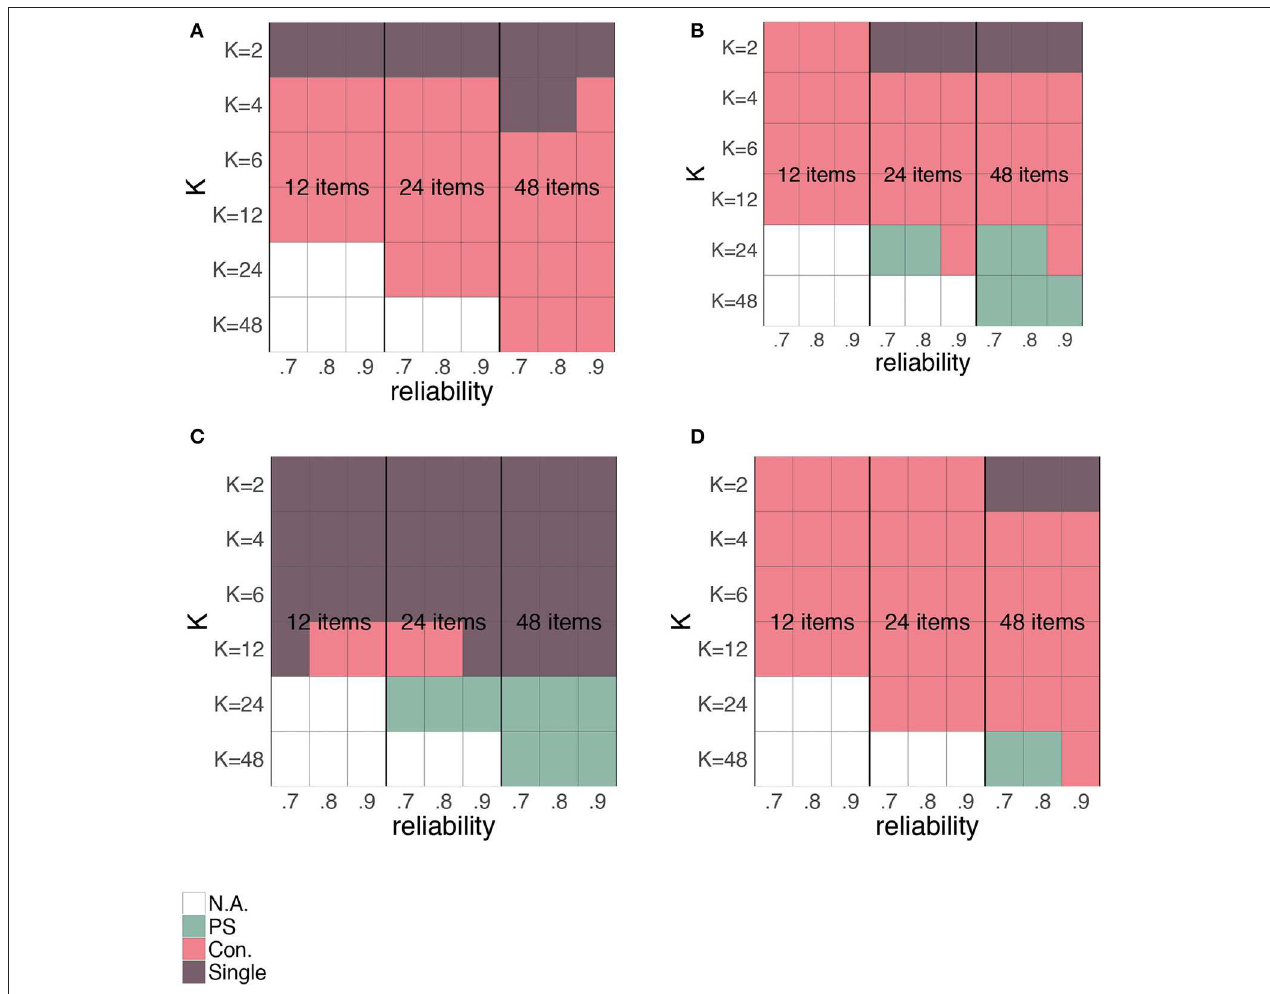
FIGURE 16 | Preference for the person-specific SEm (green), the conditional SEm (pink) or the single SEm (purple) based on the MSE for different K ’s, number of items and overall reliability. Plot (A) corresponds to the relationship between “true” scores and error variances as depicted in Figure 5A , (B) to the relationship of Figure 5B , (C) to the relationship in Figure 5C and (D) to the relationship in Figure 5D . All four plots are based on continuous parallel test